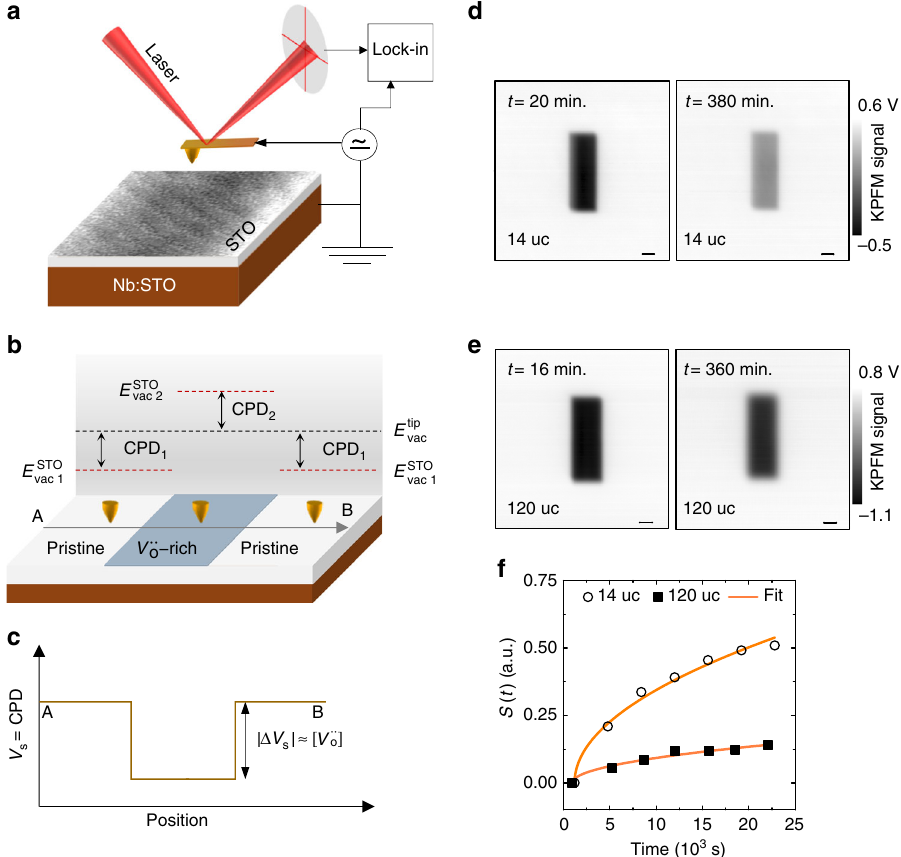
Fig. 1 Studying diffusion characteristics of oxygen vacancies with KPFM. a Sketch of the sample geometry and KPFM measurement architecture. b Schematic illustration of the contact potential difference (CPD) contrast between the pristine (referred to as 1) and V (cid:1)(cid:1) -rich (referred to as 2) regions. E vac (cid:1) (cid:3) o denotes the vacuum energy level. c Illustrative KPFM signal from a line scan from position A to B across this V (cid:1)(cid:1) -rich region. Δ V s and V (cid:1)(cid:1) denote the net o o change in the measured KPFM signal and the concentration of V (cid:1)(cid:1) within the V (cid:1)(cid:1) -rich region, respectively. d – f Characterisation of diffusion of V (cid:1)(cid:1) with the o o o KPFM technique. KPFM images around a V (cid:1)(cid:1) -enriched surface region of a 14-uc-thick d and 120-uc-thick e STO fi lms. The time lag between poling the o pristine surface and the time of acquiring an image is indicated on the top-right corner of KPFM image. The time evolution of the degree of equilibrium, S ( t ) ( solid symbols ) and fi t ( solid line ) according to Fick ’ s 2nd law of diffusion f . The scale bar in d , e represents 1 µ